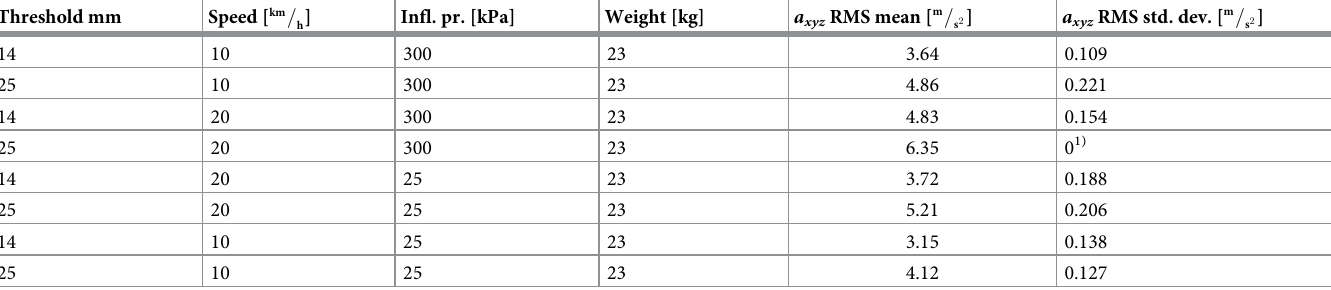
Table 2. RMS values for indoor tests over the step input (threshold height 14 resp. 25 mm) with child